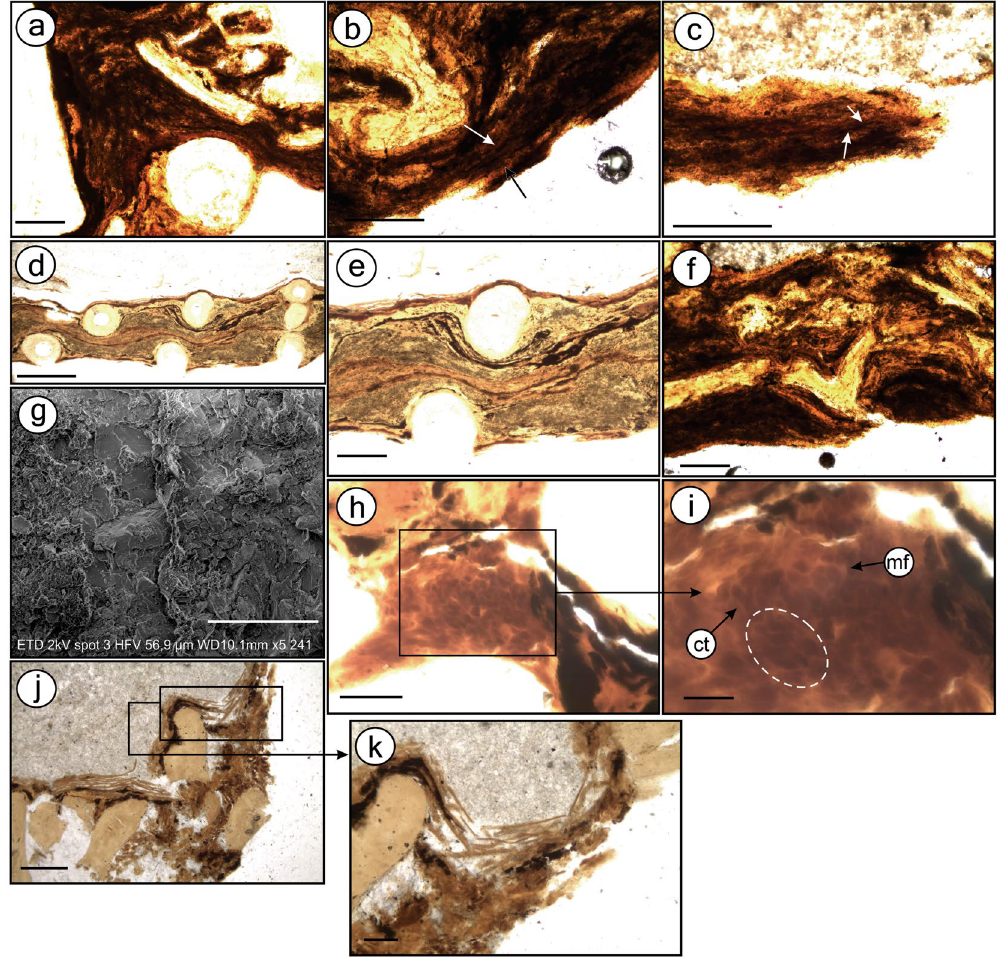
Figure 5. Thin section images and SEM of fish (Fig. 6a) with preserved carbonaceous soft-tissues. Thin sections GP/L 16 ( a – c , f , g ) and GP/L 17 ( d , e , h – k ). Dark opaque sinuous laminated, locally convolute muscle tissues ( a – c ), composed of alternating, differently coloured light/dark bands ( d , e ). Muscle tissue is composed of dark fibres ( b , c ; arrows). ( f ) Degraded soft-tissues and bones. ( g ) SEM micrograph of muscle fibre detail. ( h , i) Muscle fibres (mf) in cross-section, depicting endomysium/perimysium-like connective tissues (ct) and muscle bundles (dashed ellipsis). ( j , k ) Scales are interlayered with soft-tissues (black) and calcite cement. Scale bars: ( a – c , e , f , j , k )– 0.2 mm; ( d) – 0.5 mm; ( g) – 20 µ m; ( h )– 0.1 mm; ( i )– 0.02